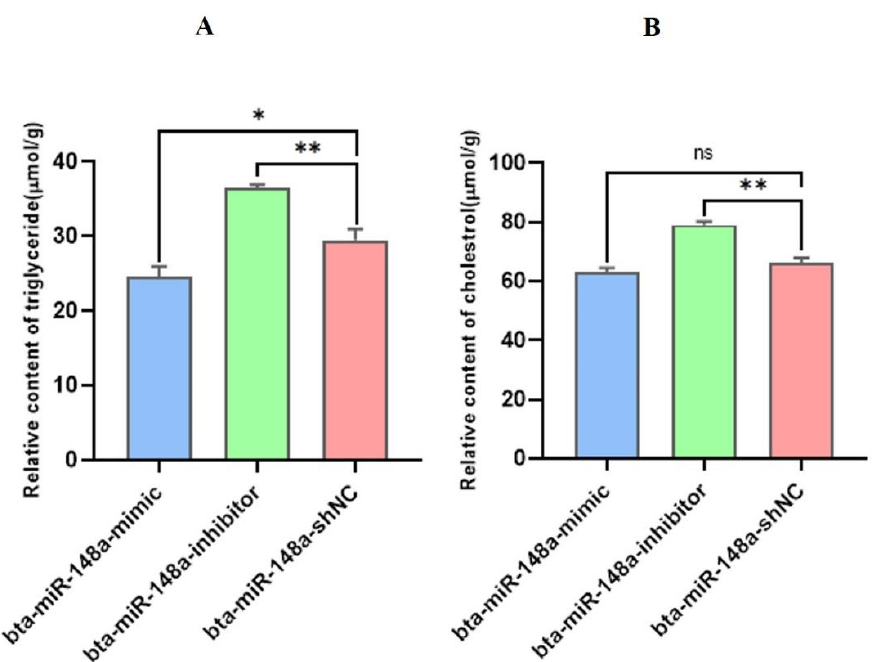
Figure 6. ( A ) TG’s relative contents in BMECs after 24 h of transfection with bta-miR-148a-mimic, inhibitor, and shNC. ( B ) Relative contents of CHO in BMECs after 24 h of transfection with bta-miR- 148a-mimic, inhibitor, and shNC. ns = non-significant * p < 0.05, ** p <